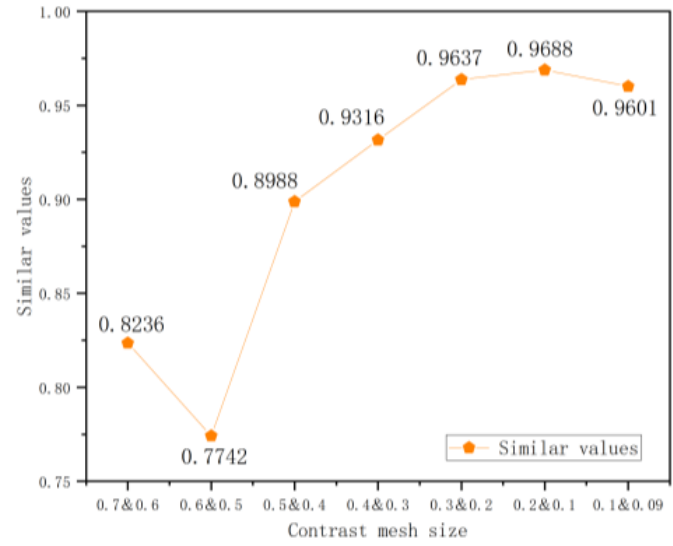
Figure 6. The results of the grid independence test